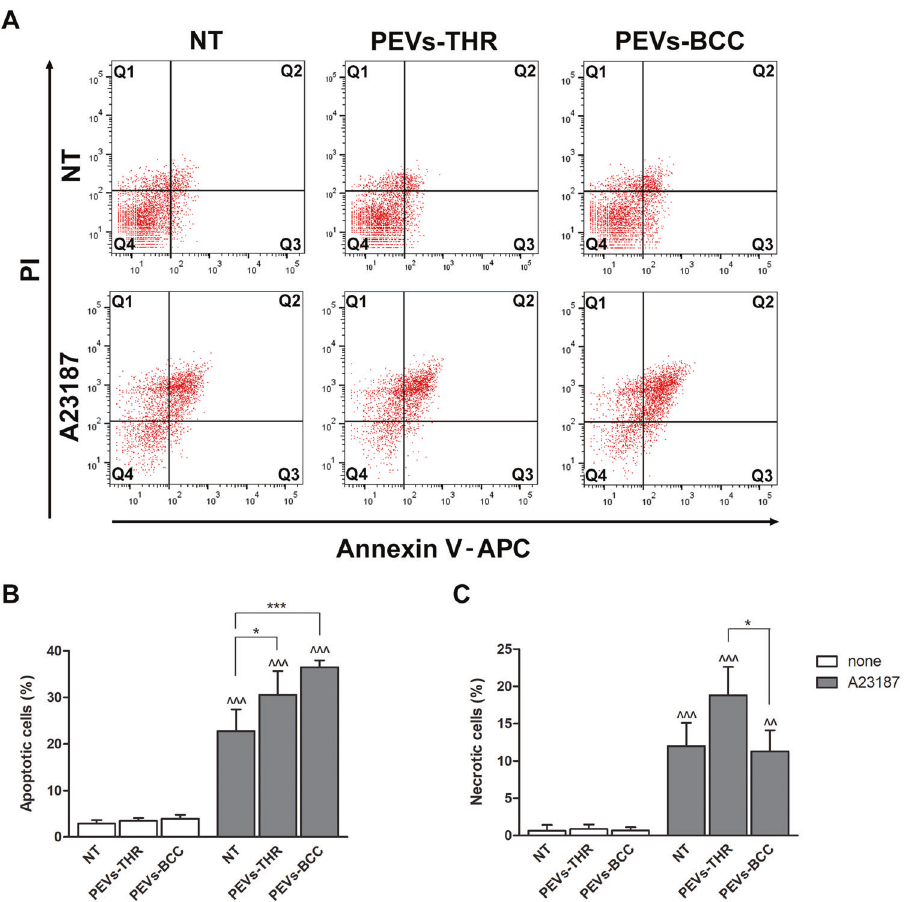
Fig. 6 Effect of PEVs on calcium-induced apoptosis in Jurkat cell. A Representative dot plots of Jurkat cell apoptosis analyzed by fl ow cytometry. The signal associated to propidium iodide (PI) and Annexin V-APC are reported on the y- and x -axis, respectively. B Quanti fi cation of apoptosis as the percentage of cells in the Q2 (late apoptosis) and Q3 (early apoptosis) quadrants. The data are representative of the mean ± SD of four independent experiments. The results of the statistical analysis of the differences between samples treated with A23187 (gray bars) and respective controls (white bars) are indicated by ^^^ ( p < 0.0001). The statistical signi fi cance of the differences between PEVs- treated samples and respective controls is indicated with the asterisks (* p < 0.05; *** p < 0.0001). C Quanti fi cation of necrotic cells as the percentage of cells in the Q1 quadrant. The data are representative of the mean ± SD of three independent experiments with * p < 0.05. The statistical signi fi cance between samples treated with A23187 (gray bars) and respective controls (white bars) are indicated by as ^ ( p < 0.05) and ^^ ( p <